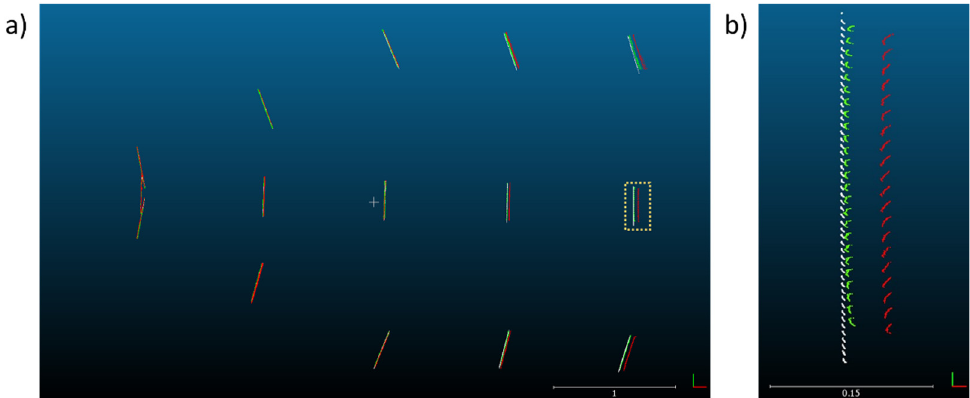
Figure 10. ( a ) A top view of the FARO (black and white), Kinect v2 (red), and Azure Kinect (green) point cloud sets after registration and segmentation. ( b ) A magnified view of board location 5 dis- playing the three point sets. The scale bar is in units of